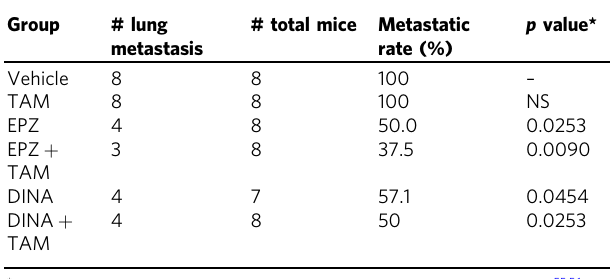
Table 4 Inhibition of CDK2/EZH2-signaling axis reduces tumor lung